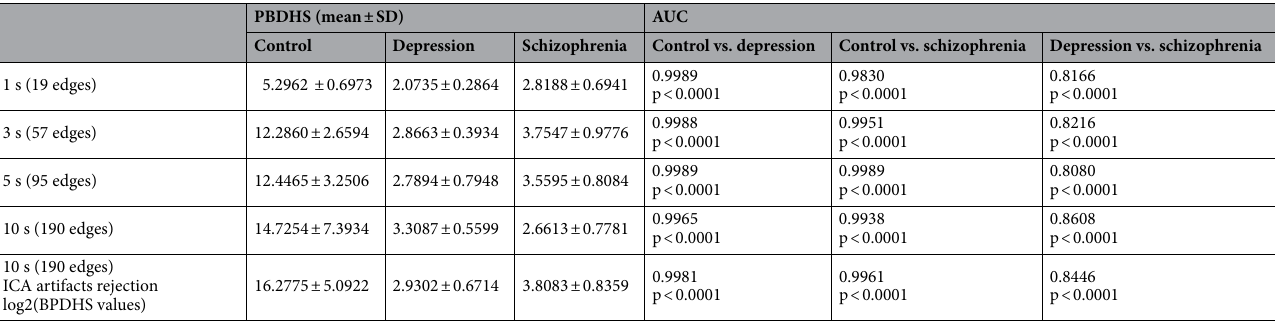
Table 1. Relationship-block subsystems PUHD values and ROC. PBDHS separation efficacy. PBDHS mean ± SD values for each patient group (first 3 columns) in each size of block dendrogram (rows 1–4). ROC analysis between pairwise patient groups (columns 4–6) in each size of block dendrogram (rows 1–4). Row 5 details analysis of EEG recording preprocessed with ICA artifact components rejection: first 3 columns- PBDHS mean ± SD values for each patient group in block dendrogram size of 190 events. columns 4–6 of Row 5 details ROC analysis between pairwise patient groups in block dendrogram size of 190 events.